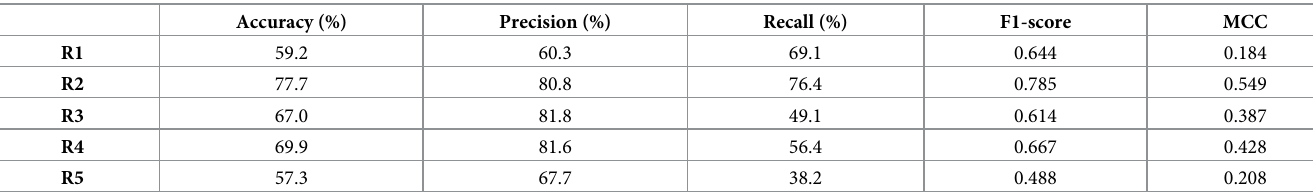
Table 4. Visual Turing test result